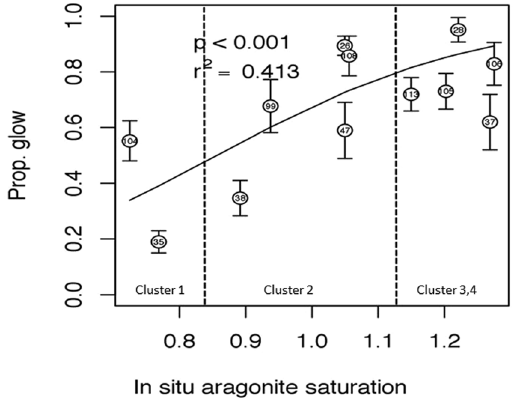
Figure 4. The changes in pteropod calcification depicted as a proportional glow, at the range of in situ conditions from 12 different stations characterized by the difference in carbonate chemistry. The regression line from a general linear model with logit-link and beta error distribution indicates positive correlation between aragonite saturation (Ω ar ) and proportional glow. Pteropods coming from high in situ Ω ar demonstrate high glow of calcein in their shell, shown also visually in Fig. 5a and 5b Vertical lines indicate groupings based on the cluster analysis of stations; Cluster Group 1 ( Ω ar < 0.8; stations 35 and 104), Cluster Group 2 (0.8 < Ω ar < 1; stations: 47, 108, 26, 38, 99), and Cluster Group 3 and 4 ( Ω ar > 1.2; stations: 28, 37, 106, 105, 113). Error bars indicate ± 1.0 standard errors. The average in situ Ω ar of three groupings identifies two aragonite saturation state thresholds with respect to proportional glow; Ω ar > 1.2 and Ω ar < 0.8. Error bars indicate ± 1.0 standard errors, N = 96 (Table S3). Proportional glow and Ω ar are related through the following equation: ln (% glow/(1-% glow)) = b 0 + b 1 * ( Ω ar ) = − 4.34( ± 0.19 s.e.) + 5.07( ± 0.18 s.e.) * Ω ar